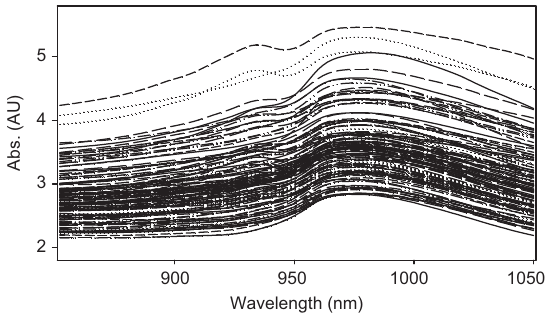
Figure 3 The 129 raw calibration spectra of tecator data.